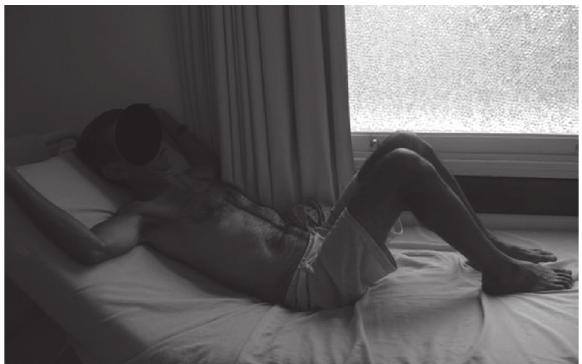
Figura 1 - Posicionamento em decúbito dorsal com a